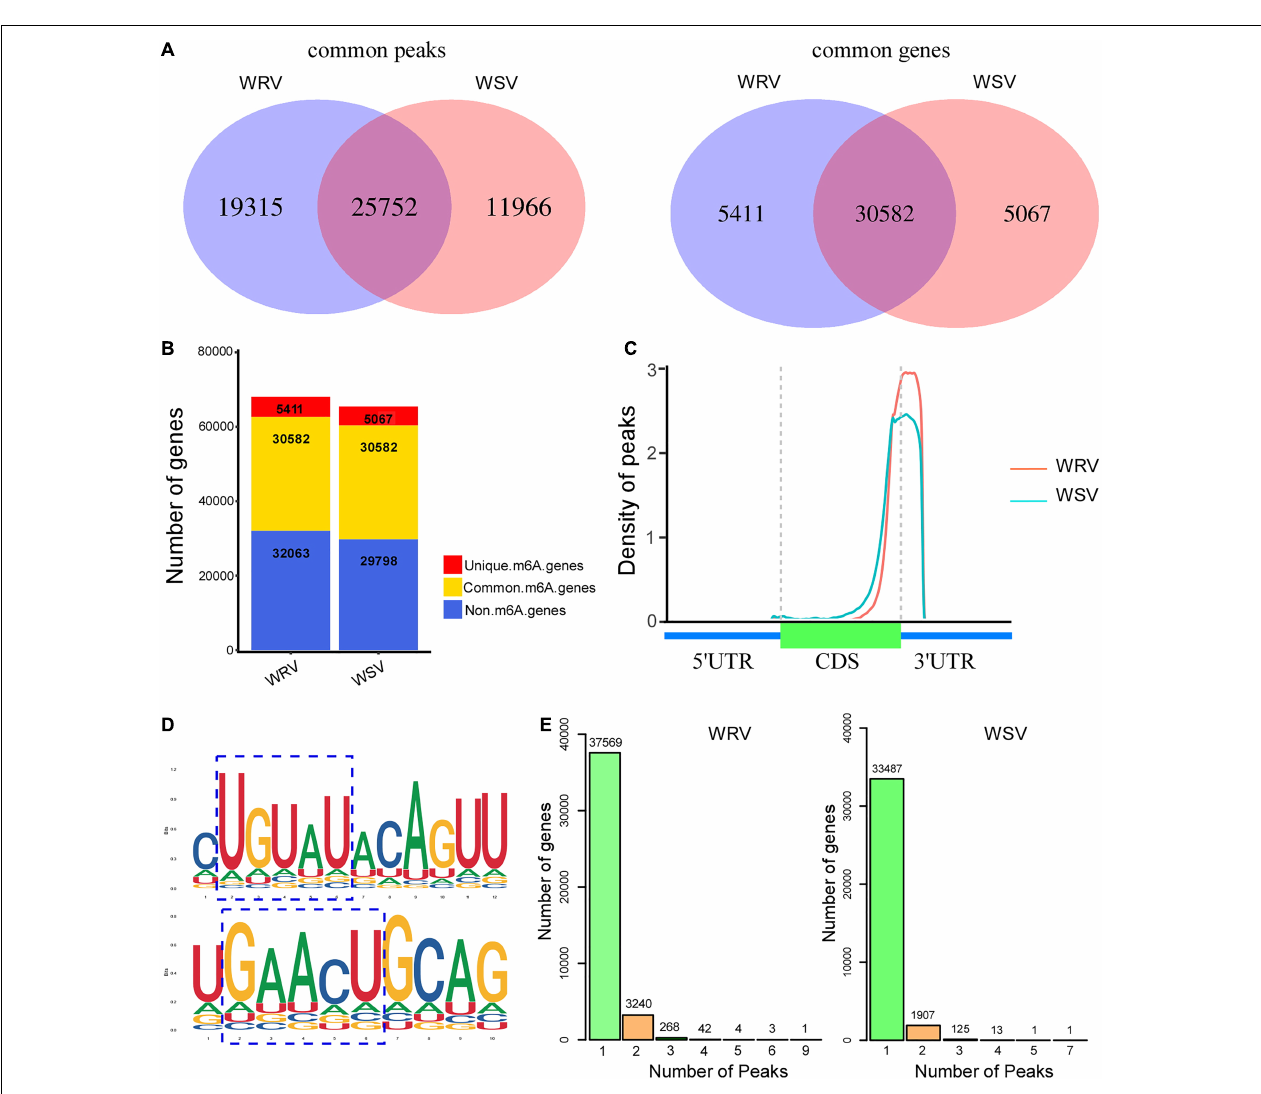
FIGURE 1 | Overview of m 6 A methylome in two varieties of wheat and analysis of m 6 A peaks. (A) Left : numbers of WRV unique peaks and WSV unique and common peaks. Right : numbers of these peaks represent genes of the two groups. (B) Numbers of m 6 A-modified genes identified in m 6 A-seq data. (C) Density of m 6 A peaks along the wheat genome, which was divided into three non-overlapping regions, including 5 (cid:48) -UTR, CDS, and 3 (cid:48) -UTR. (D) Two top m 6 A motifs were enriched in all identified m 6 A peaks, RRACH and UGUAY (R is A/G, H is A/C/U, and Y is C/U). The blue dotted line box represented the conserved m 6 A motifs. (E) Numbers of m 6 A methylated genes with different numbers of m 6 A peaks in the two groups. WRV, WYMV-infected resistant wheat variety; WSV, WYMV-infected sensitive wheat variety.